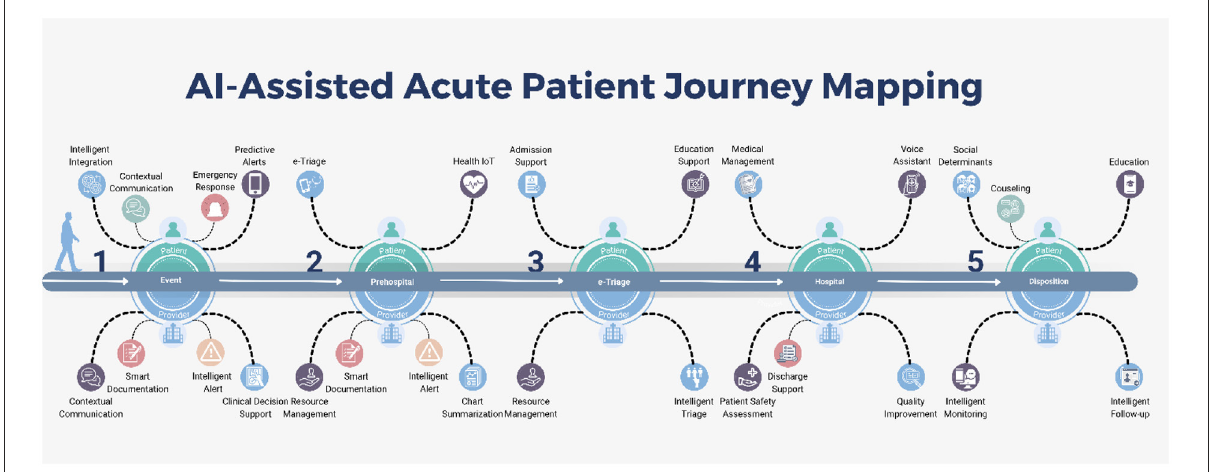
FIGURE1 Al-Assisted Acute Patient Journey Mapping.